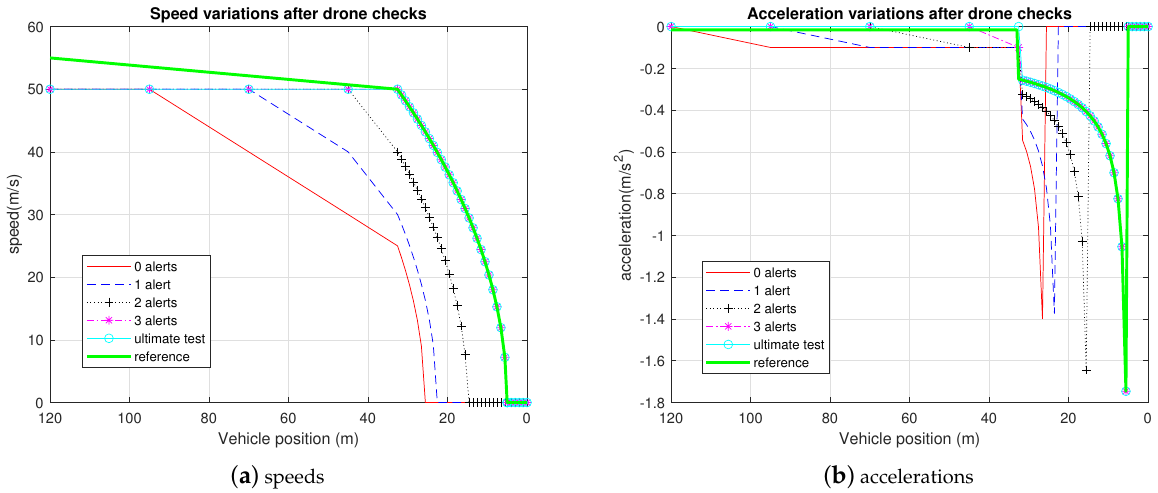
Figure 10. Speeds and accelerations of driver type 1, case of dry curved line.